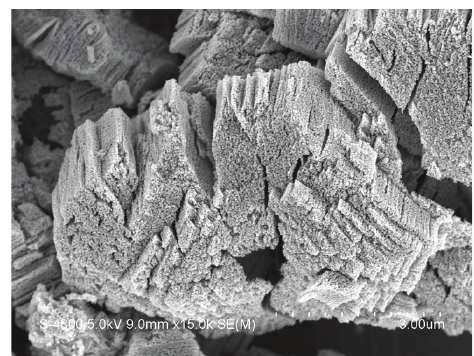
Figure 3: FESEM image of the ZnONPs ( ×15000